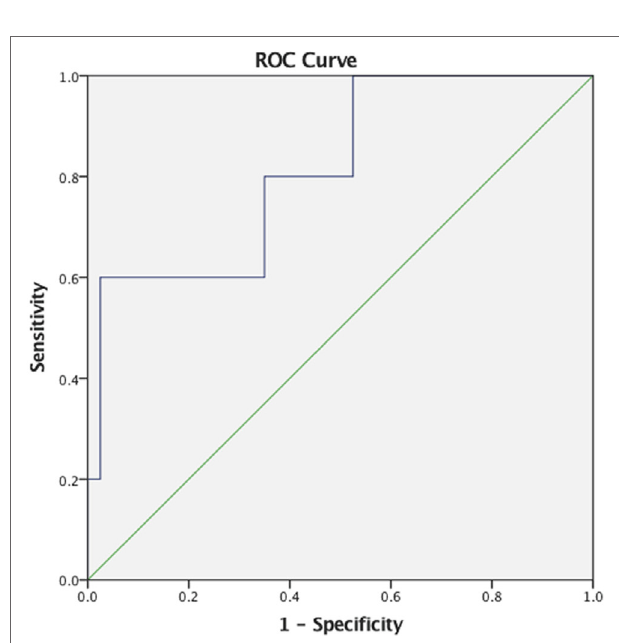
FigUre 2 | Receiver operating characteristics (ROC) curve for maximum fundamental frequency as a predictor of small liquid bolus silent aspiration (Penetration/Aspiration Scale score 8).